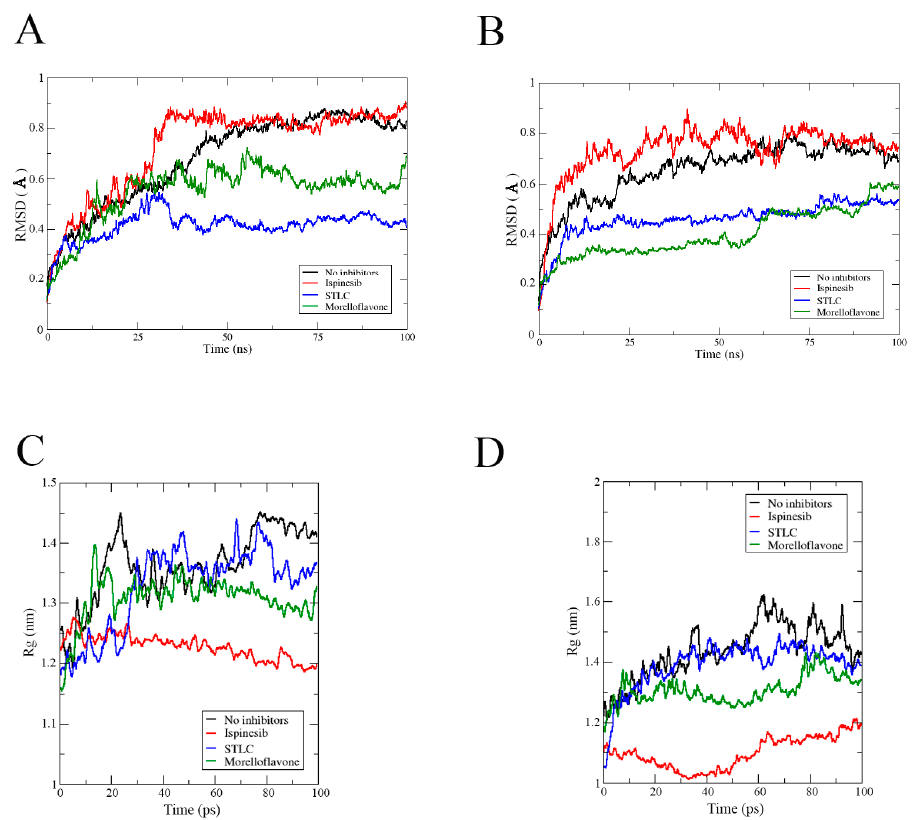
Figure 5. RMSD profiles of the allosteric pocket in Eg5 in the presence of ( A ) ADP and ( B ) ATP. Rg values of the Eg5 allosteric pocket in the presence of ( C ) ADP and ( D ) ATP. 2.4. Binding of MF on the Allosteric Site Alters the Eg5 Structural In this range, we found the residues Thr112, Phe113, Met115, Glu116, Gly117, Glu118, Arg119, Ser120, Trp127, Glu128, Leu132, Ala133, Gly134, Ile136, Pro137, Arg138, Leu171, Leu172, Tyr211, Ile213, Leu214, Glu215, Lys216, Ala218, Ala219, Lys220, Arg221, Thr222, and Phe239, which were